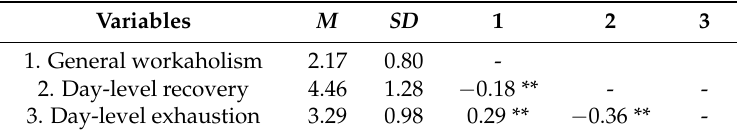
Table 1. Means, standard deviations and correlations among the study variables.